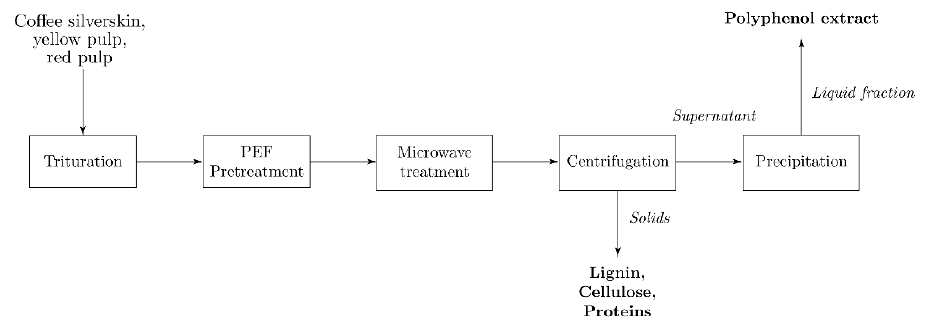
Figure 8. Pulsed-electric field (PEF) pretreatment and microwave-assisted extraction (MAE) meth- odology flow diagram.